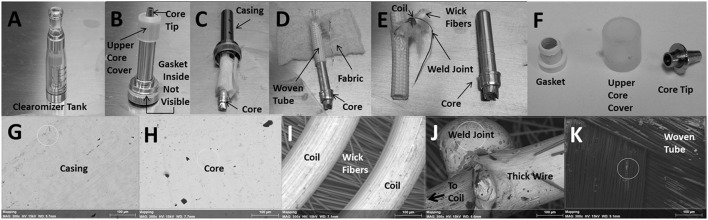
Anatomy of the core assembly depicting (A) plastic “clearomizer” tank, (B) encased core, (C) core wrapped in fabric, (D) core within woven tube, (E) exposed core, woven tube and coil and (F) gasket, upper core cover, and core tip. SEM images of the (G) inner surface of core casing, (H) core, (I) coils surrounding wick fibers, (J) weld joint between coil and extension wire and (K) inner surface of woven tube. The small white circle, where visible, indicates the area in which elemental analysis was performed (see Table 2). All SEM images were observed at an acceleration voltage of 15 kV and are depicted at a magnification of 300X.